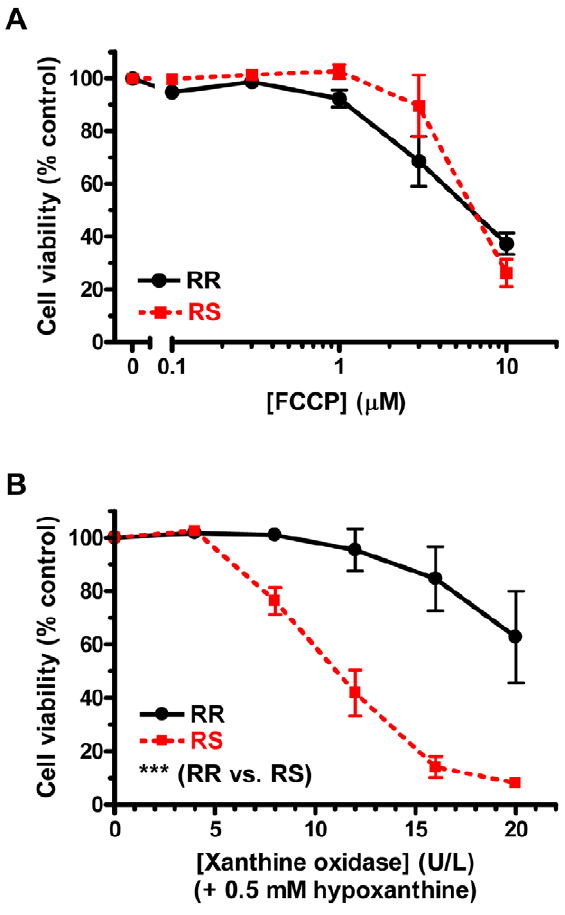
Figure 3. Differential vulnerability to ATP depletion and oxidative stress. A . CRI-G1-RR and RS cells are equally vulnerable to mitochondrial uncoupler FCCP, which leads to ATP depletion. B . CRI- G1-RS cells are more vulnerable than RR cells to oxidative stress